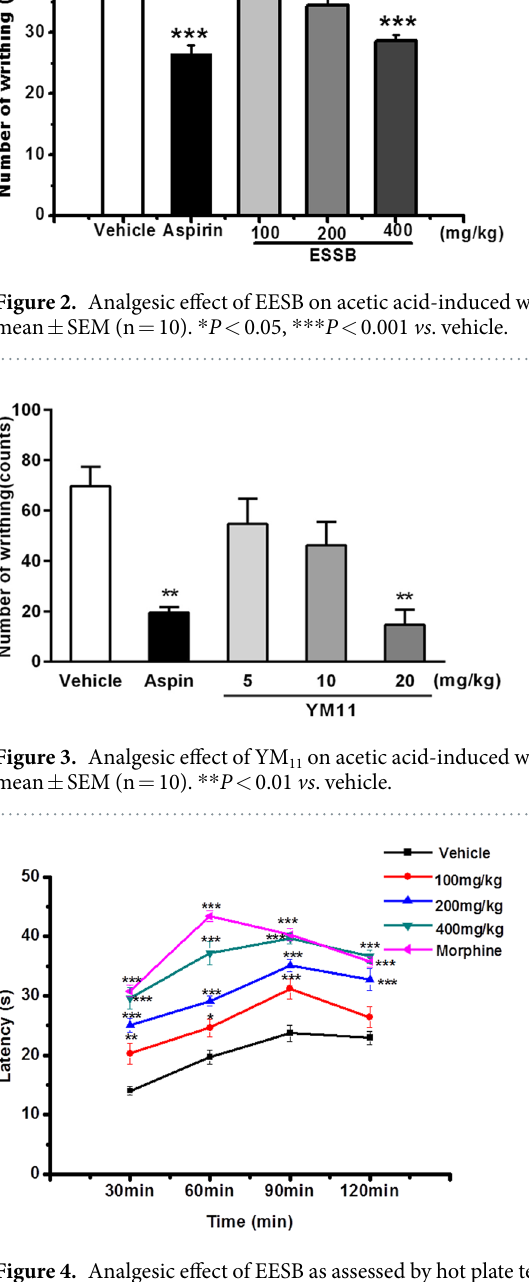
Figure 4. Analgesic effect of EESB as assessed by hot plate test in mice. Results are expressed as mean ± SEM (n = 10). * P < 0.05, ** P < 0.01, *** P < 0.001 vs .